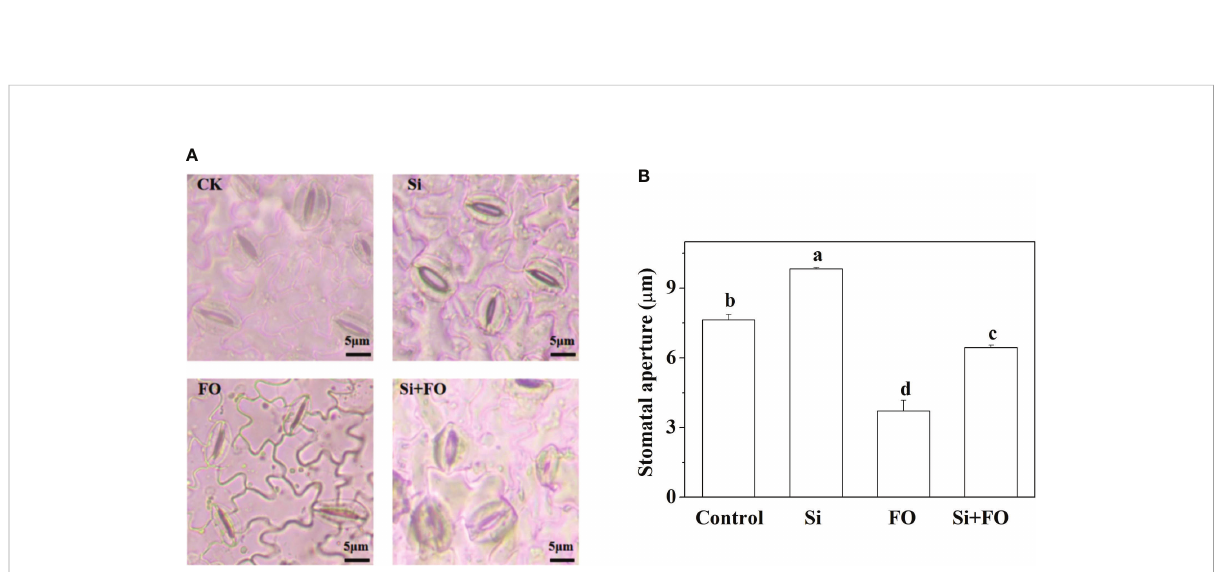
FIGURE 9 Effects of exogenous silicon application on stomatal movement in the lower epidermis of cucumber leaves. (A) Microscopic photographs of stomata in the lower epidermis, and (B) stomatal aperture as in fl uenced by different treatments. Means denoted by the different lowercase letters are signi fi cantly different according to Tukey ’ s test ( P ≤ 0.05). CK or Control: plants were irrigated with sterilized water; Si: plants were irrigated with exogenous silicon (3 mmol·l -1 Si); FO: plants were only inoculated with Fusarium ; Si+FO: plants were irrigated with exogenous silicon followed by inoculation with Fusarium